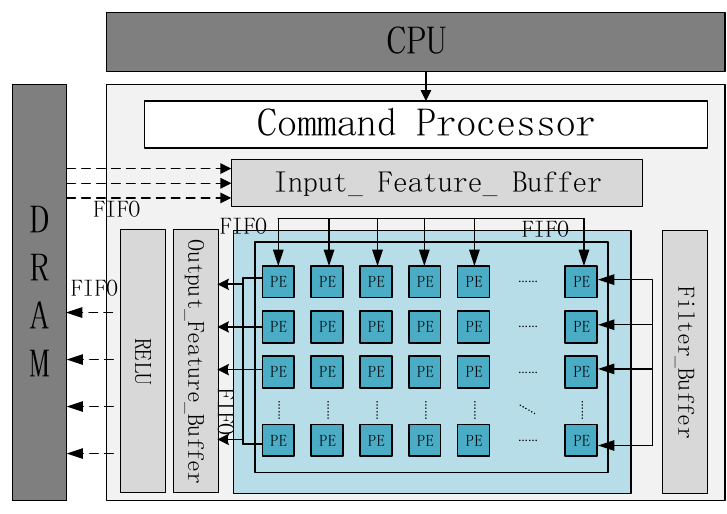
Figure 8. Accelerator structure overview .